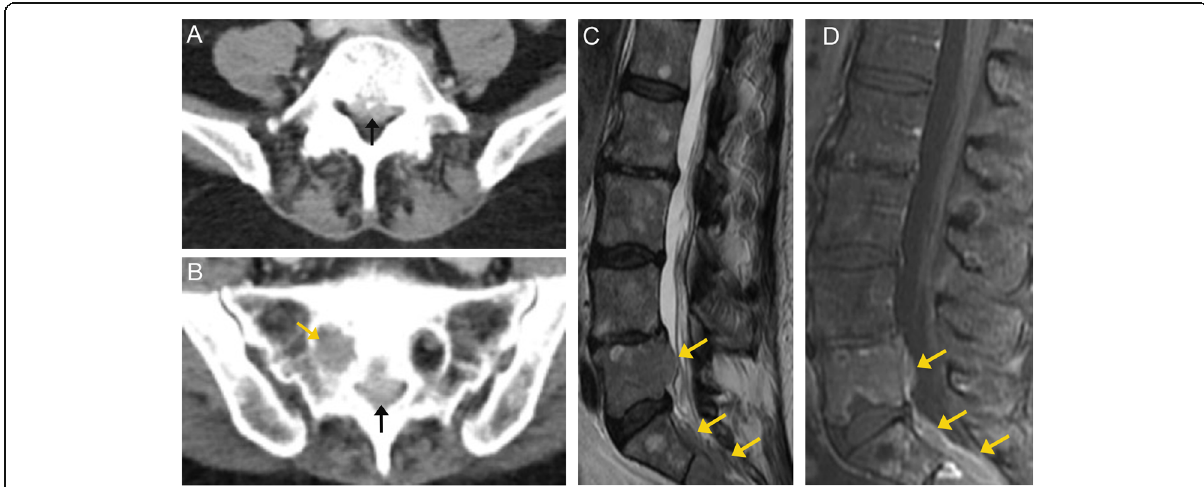
Fig. 16 Lymphoma. Axial CT images through the lumbar spine ( a ) and sacrum ( b ) demonstrate abnormal soft tissue within the spinal canal (black arrows). Additionally, there is soft tissue replacement of the normal fat in the right sacral foramen (orange arrow). T2-weighted MR image ( c ) of the lumbosacral spine demonstrates an intermediate to low signal lesion involving the posterior aspect of L5, and another component at S1-S2 (orange arrows). There is no involvement of the intervertebral discs. Post-contrast T1-weighted fat-suppressed image ( d ) demonstrates relatively homogeneous enhancement